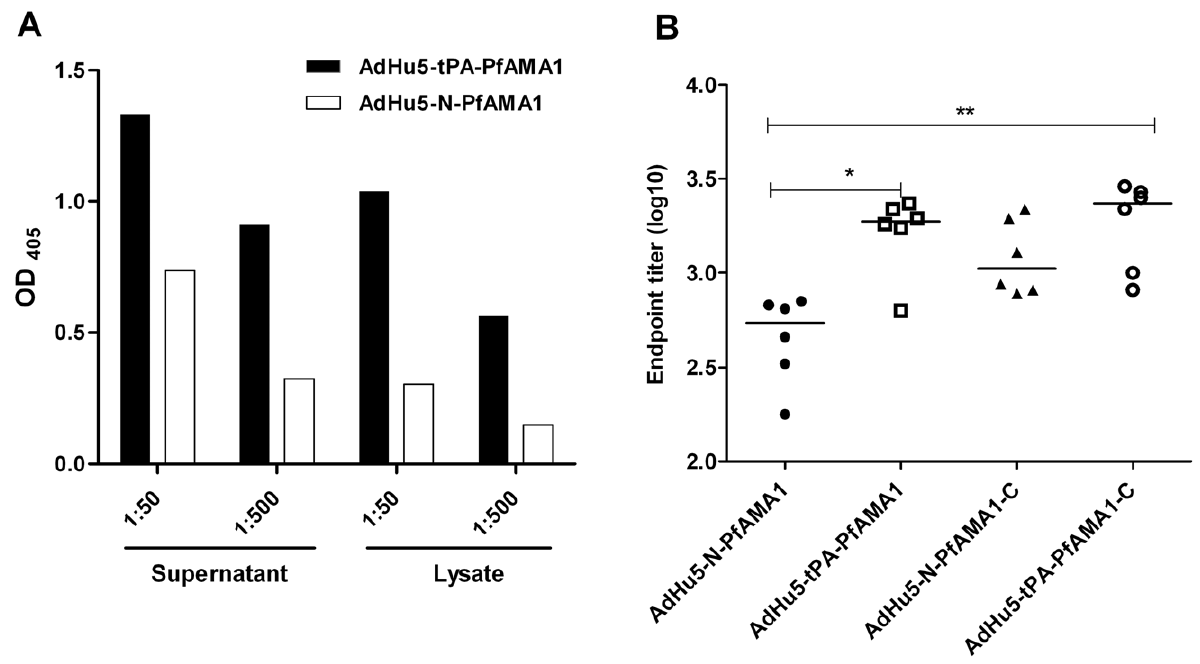
Figure 5. Use of a mammalian secretory signal sequence enhances antigen expression and antibody immunogenicity of an AdHu5 vectored PfAMA1 vaccine. (A) A549 cells were infected either with the same number of infectious units of AdHu5-tPA-PfAMA1 or AdHu5-N- PfAMA1. The quantity of PfAMA1 protein was assessed in the supernatant and lysate by a PfAMA1 capture ELISA. The figure shows the OD 405 values for both the supernatant and the lysate for the two constructs. (B) Four groups of 5–6 week old female BALB/c mice were immunized with one of the four constructs i) AdHu5-tPA-PfAMA1, ii) AdHu5-tPA-PfAMA1-C, iii) AdHu5-N-PfAMA1, or iv) AdHu5-N-PfAMA1-C at a dose of 1 6 10 10 vp. The total IgG response was measured by ELISA in the serum 12 days after immunization against P. falciparum 3D7 recombinant protein. The median and endpoint titers (log 10) for individual mice are shown. The asterisk indicates a significant difference in endpoint titer between the groups by ANOVA (* P # 0.05, ** P # 0.01).